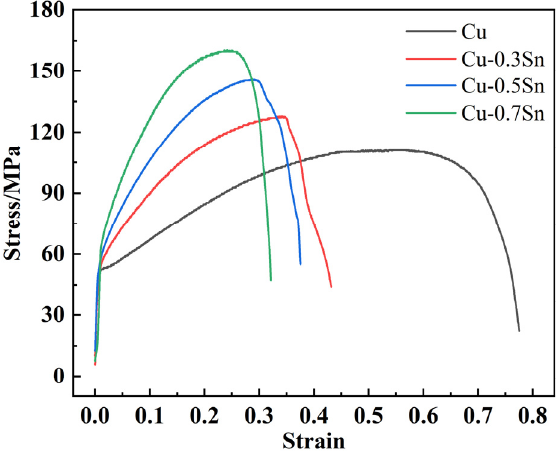
Figure 4. The stress–strain curves of Cu alloys with different Sn contents. Table 1. The different Sn contents: experimental